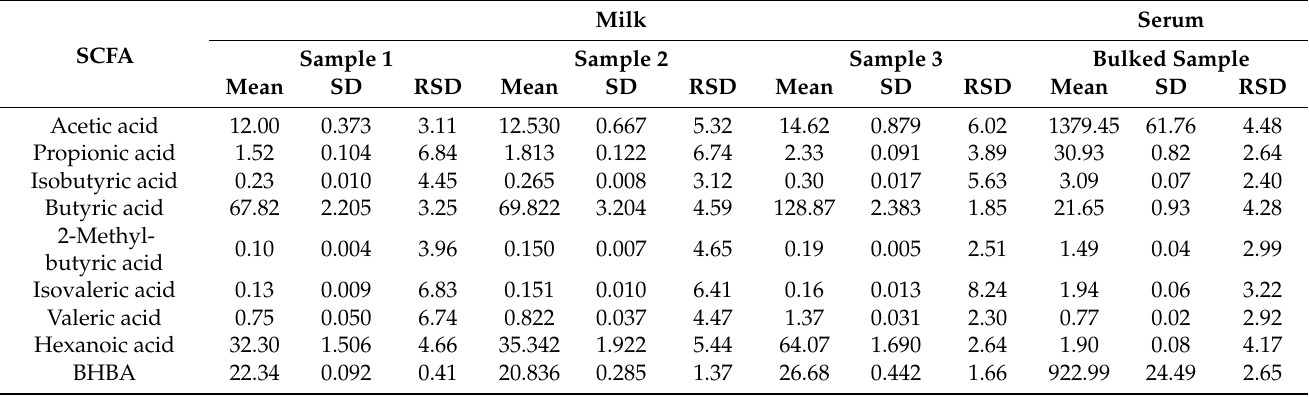
Table 2. Mean concentrations and SD ( µ mol/L), and RSD (%, n = 5) of derivatised SCFA and BHBA in three raw milk and one bulked serum samples.